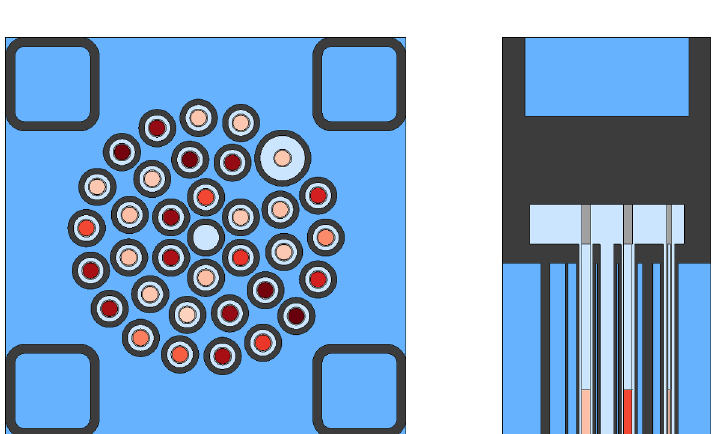
Figure 1: Left: radial cut of quiver. The rods are color coded according to burnup (darker red denotes higher burnup) Right: axial cut of the top of the quiver. (colors: dark gray - steel, light gray - zirconium, light blue - helium, blue - water, reds -